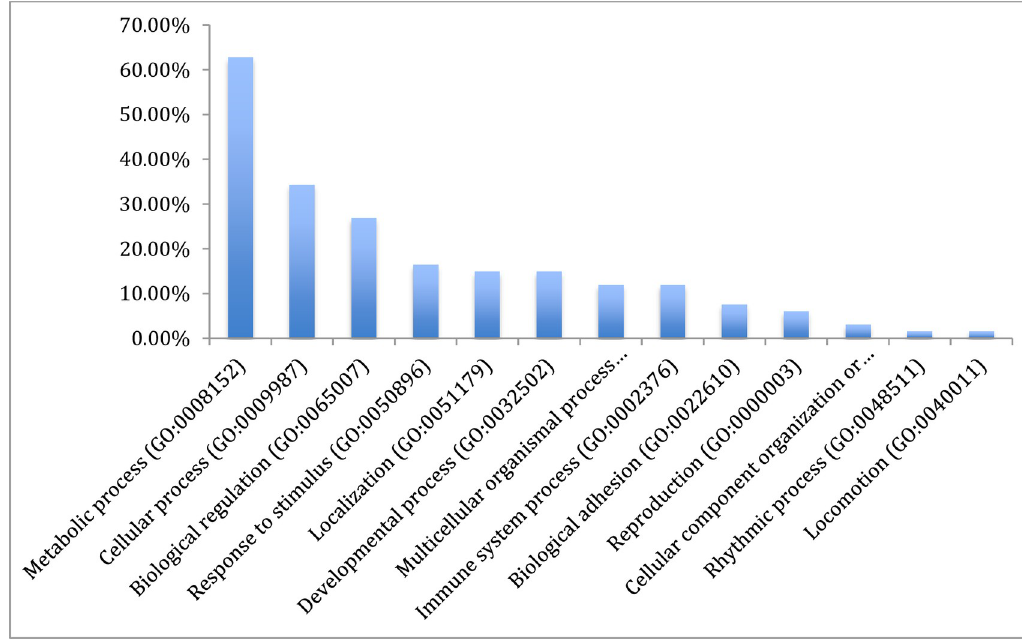
Fig 2. Gene ontology classification of the assembled transcripts of the Nile crocodile showing the percentages of genes involved in various biological functions.